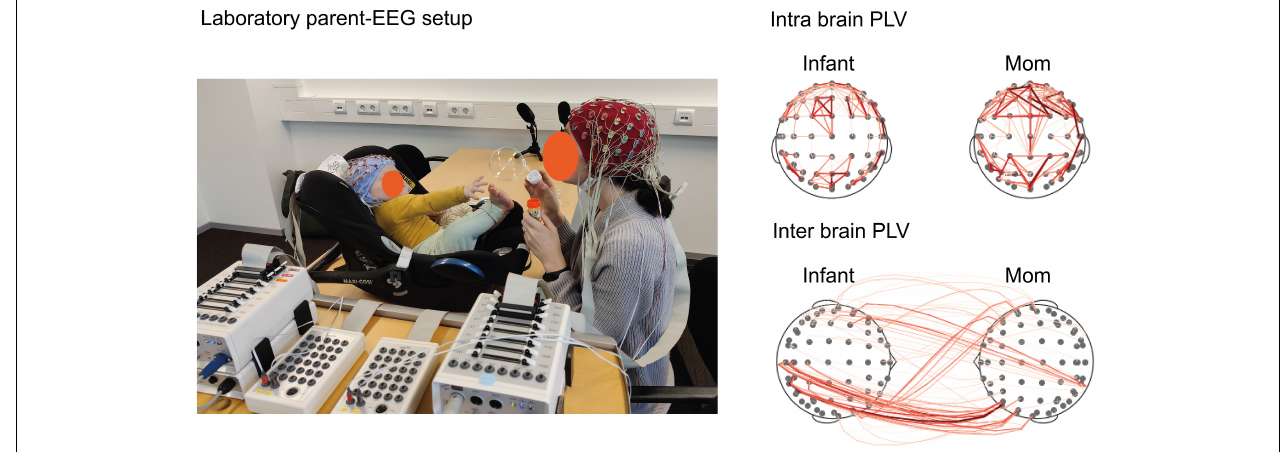
FIGURE 1 | Parent–infant EEG setup and exemplary data. ‘ Lab setting’ on the (Left) , image is showing our lab’s parent–infant dual-EEG setup using BioSemi ActiveTwo. The infant is placed in a baby car seat on top of the table which enables the direct eye contact between parent and infant. The parent (red) and infant (light blue) caps with 64 electrodes (installed after cap placement) are each connected to a separate AD-Box that is interconnected with the other AD-Box. For technical details of the BioSemi setup, see Barraza et al. (2019). For this explanatory guideline we used the free play task as paradigm of 3 min, while recording dual-EEG, video and audio. EEG measures during free play represents the brain state of natural interaction between parent and infant. ‘Intra brain and inter brain visualization’ on the (Right) , image is showing PLV connectivity based on infant Alpha (6–9 Hz). The visualizations are based on one dyad from the (freely available) dataset for this study including the data of 2 mother–infant dyads and are analyzed in HyPyP. Infant’s age was 11 months. The connections (red lines) represent positive significant associations, the thickness of the lines represents the connectivity strength (PLV values transformed to Cohen’s D , threshold = 2). Dyads were included from Tilburg University’s Brains-In-Sync cohort (PI: van den Heuvel). Privacy note : the neural data does not correspond to the mom and infant on the